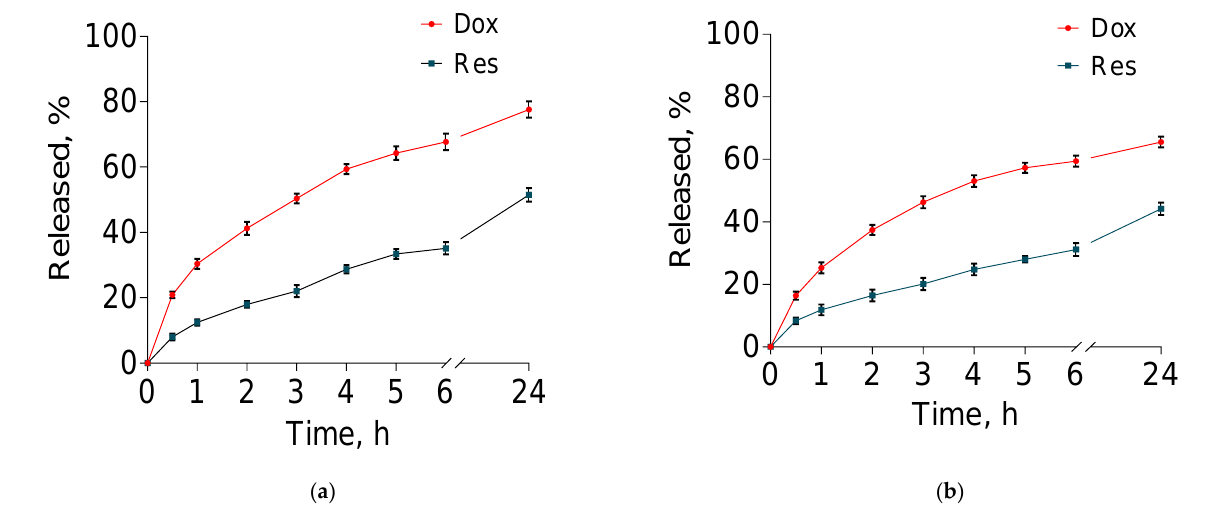
Figure 7. In vitro release profiles of doxorubicin and resveratrol from the double-loaded micelles in buffers with pH = 5 ( a ) and pH = 7.4 ( b ). buffers with pH = 5 ( a ) and pH = 7.4 ( b ). Table 2. Kinetic parameters for release data fitted to the Korsmeyer–Peppas Table 2. Kinetic parameters for release data fitted to the Korsmeyer–Peppas model.